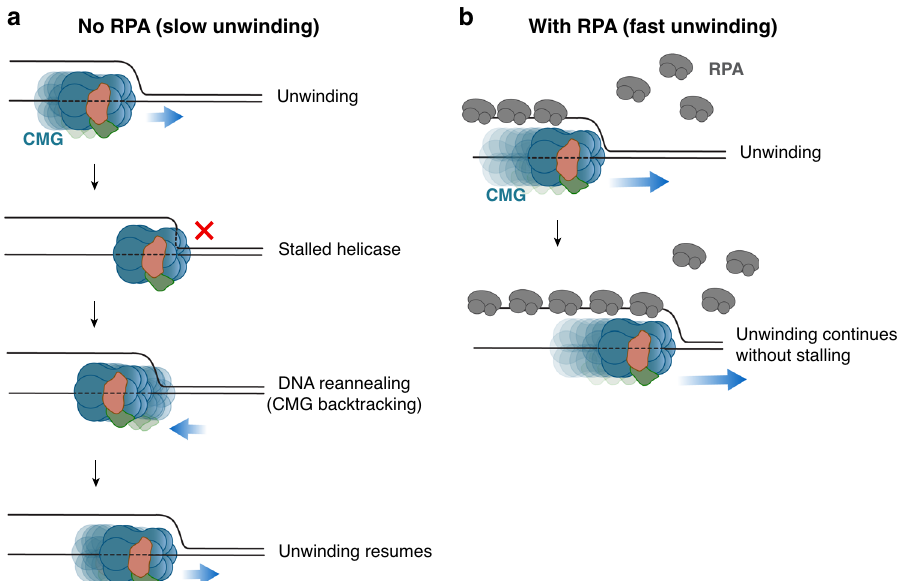
Fig. 8 Model for RPA-facilitated DNA unwinding by CMG. a While unwinding dsDNA, CMG often pauses owing to engagement with the parental duplex at the fork junction. DNA rezipping-induced CMG backtracking can rescue a stalled helicase. Owing to frequent pausing, CMG unwinds duplex DNA very slowly. b Binding of RPA to the lagging-strand template prevents CMG from engaging with duplex DNA at the fork junction. Thus, in the presence of RPA, CMG unwinds dsDNA at rates similar to its ssDNA translocation